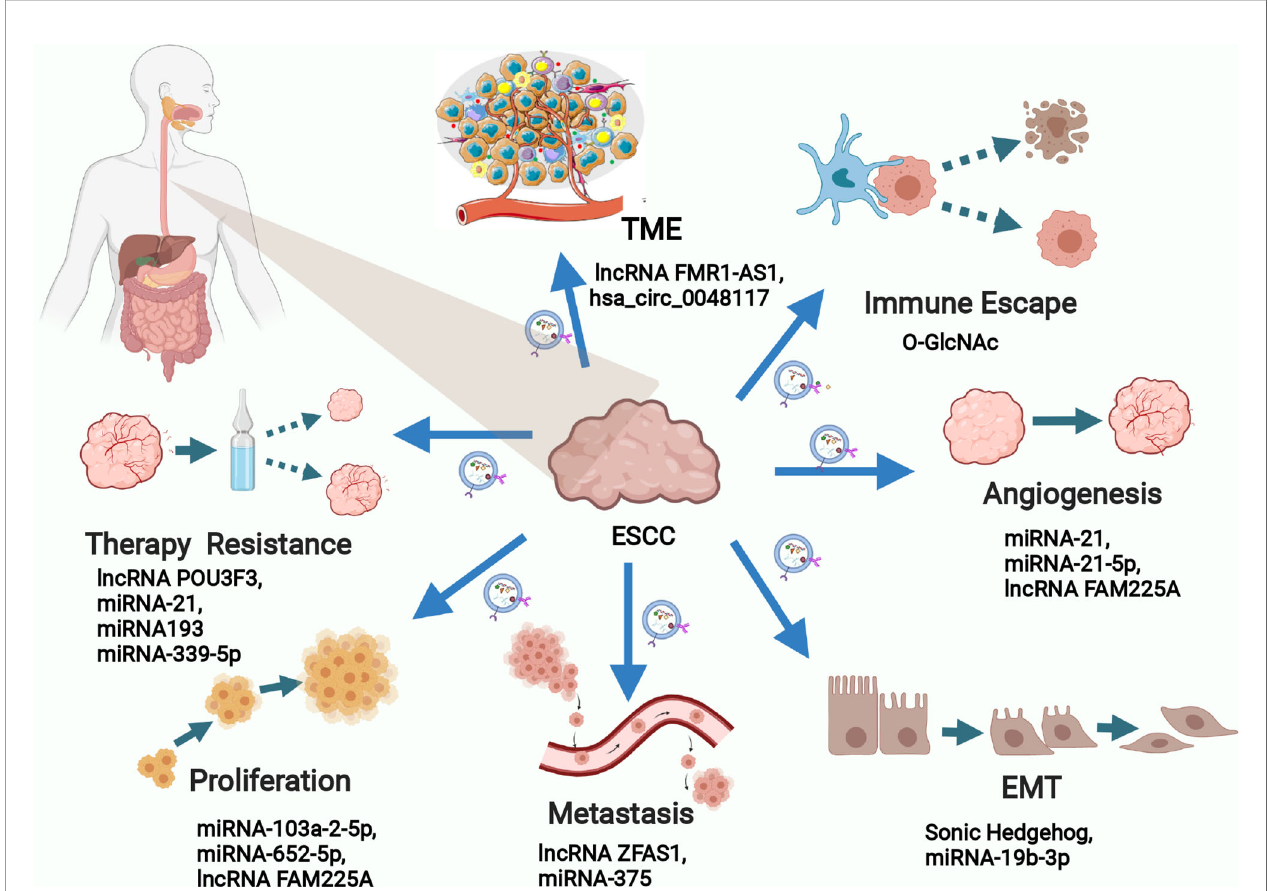
FIGURE 3 | The biological function of exosomal cargos in the development of